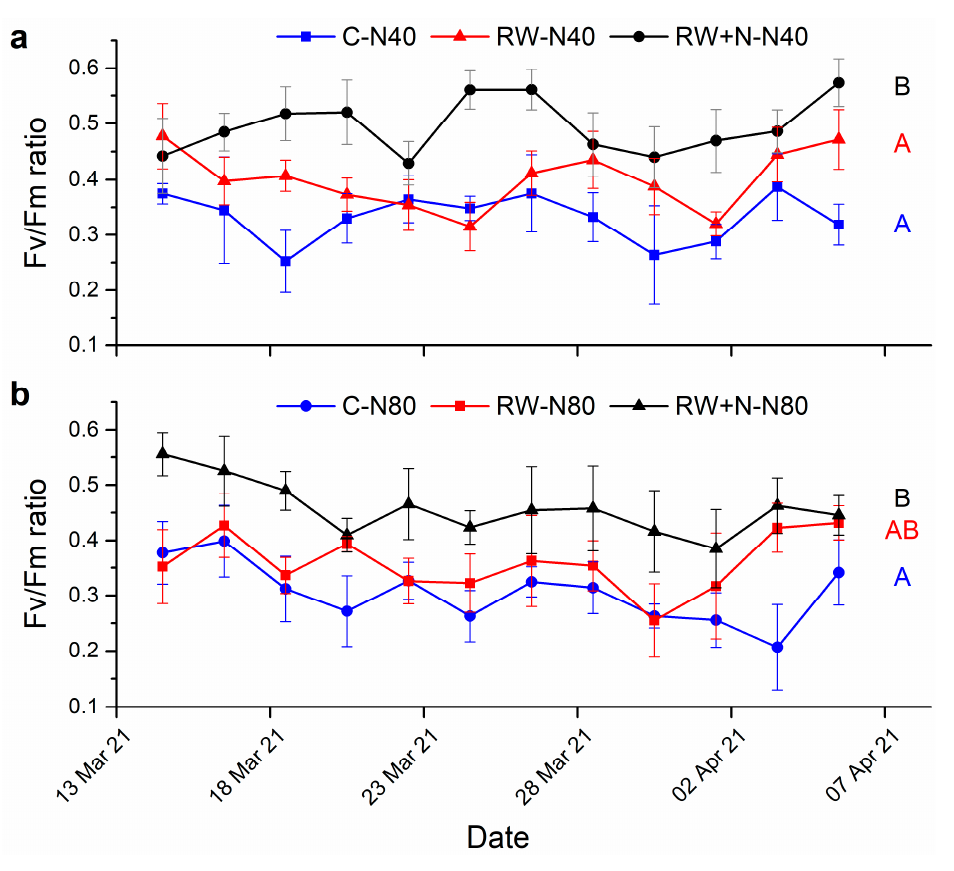
Figure 3. Temporal changes in Fv/Fm ratio during phase 2 of the experiment receiving 40 ( a ) and 80 ( b ) kg N h − 1 year − 1 . Control samples in phase 1 (watered every day, blue dots) are labeled as C-N40 and C-N80, respectively. RW samples in phase 1 (watered twice per week, red squares) are labeled as RW-N40 and RW-N80, respectively. RW+N samples in phase 1 (watered twice per week with 40 kg N h − 1 y − 1 , black triangles) are labeled as RW+N40 and RW+N80, respectively. Uppercase letters indicate significant differences among treatments.